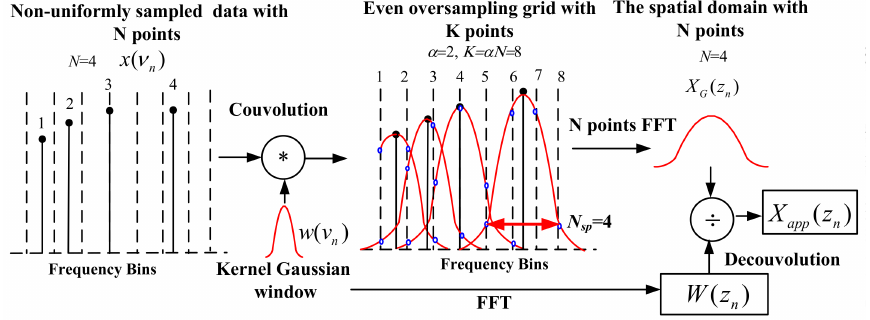
Figure 5. Signal processing procedure of NUFFT (Reprinted from Ding et al. [29]. with permission of AIP Publishing LLC; copyright